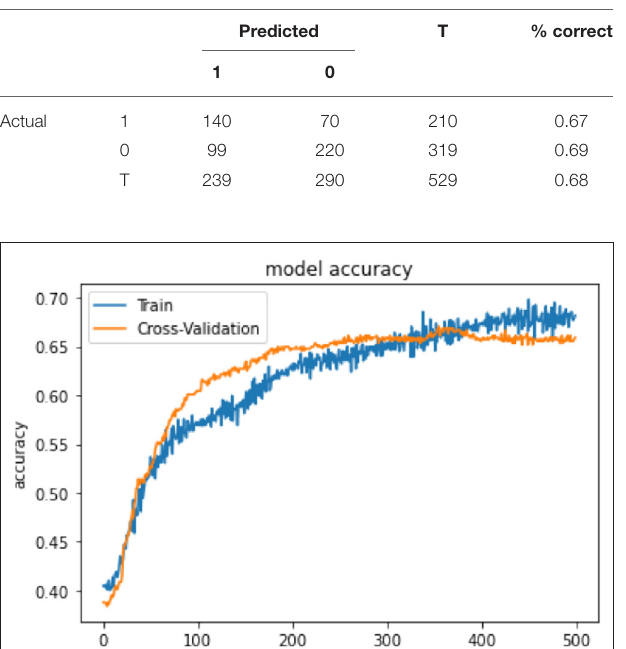
TABLE 14 | ANN confusion (classification) matrix—pooled data.